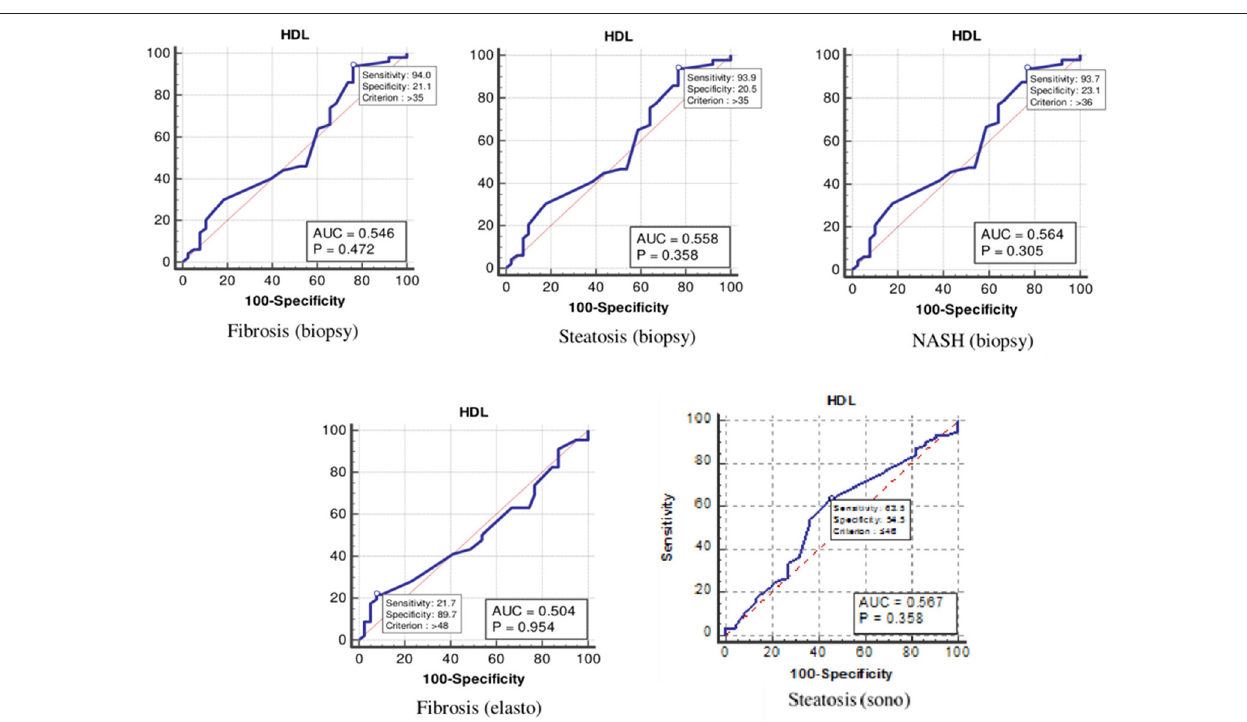
FIGURE 4 | The receiver operating characteristics curve for low-density lipoprotein cholesterol in the detection of liver disease.